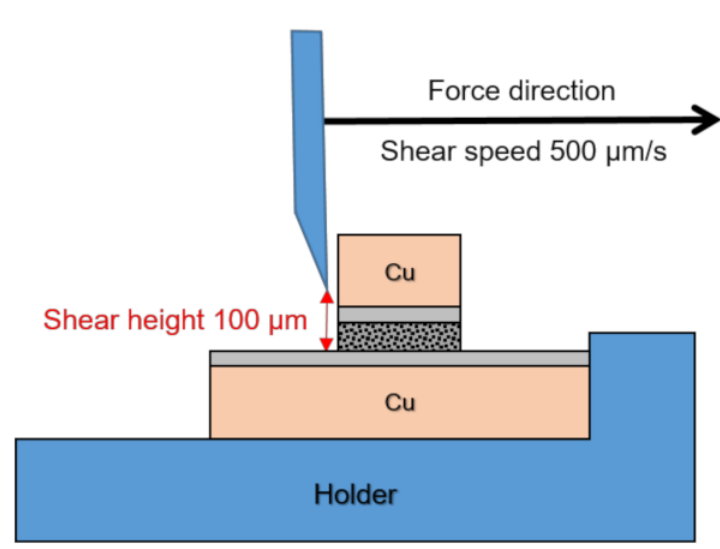
Figure 4. Schematic of the die shear